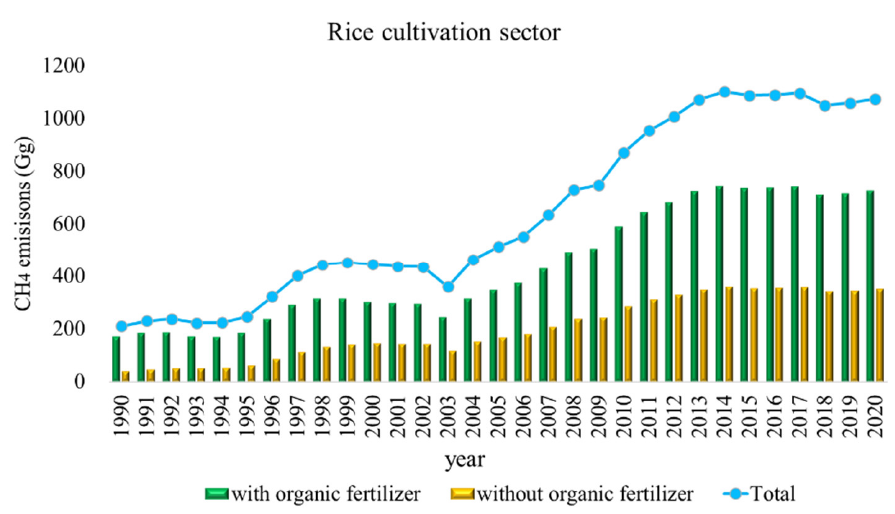
Figure 5. CH 4 emissions from rice cultivation, 1990–2020.